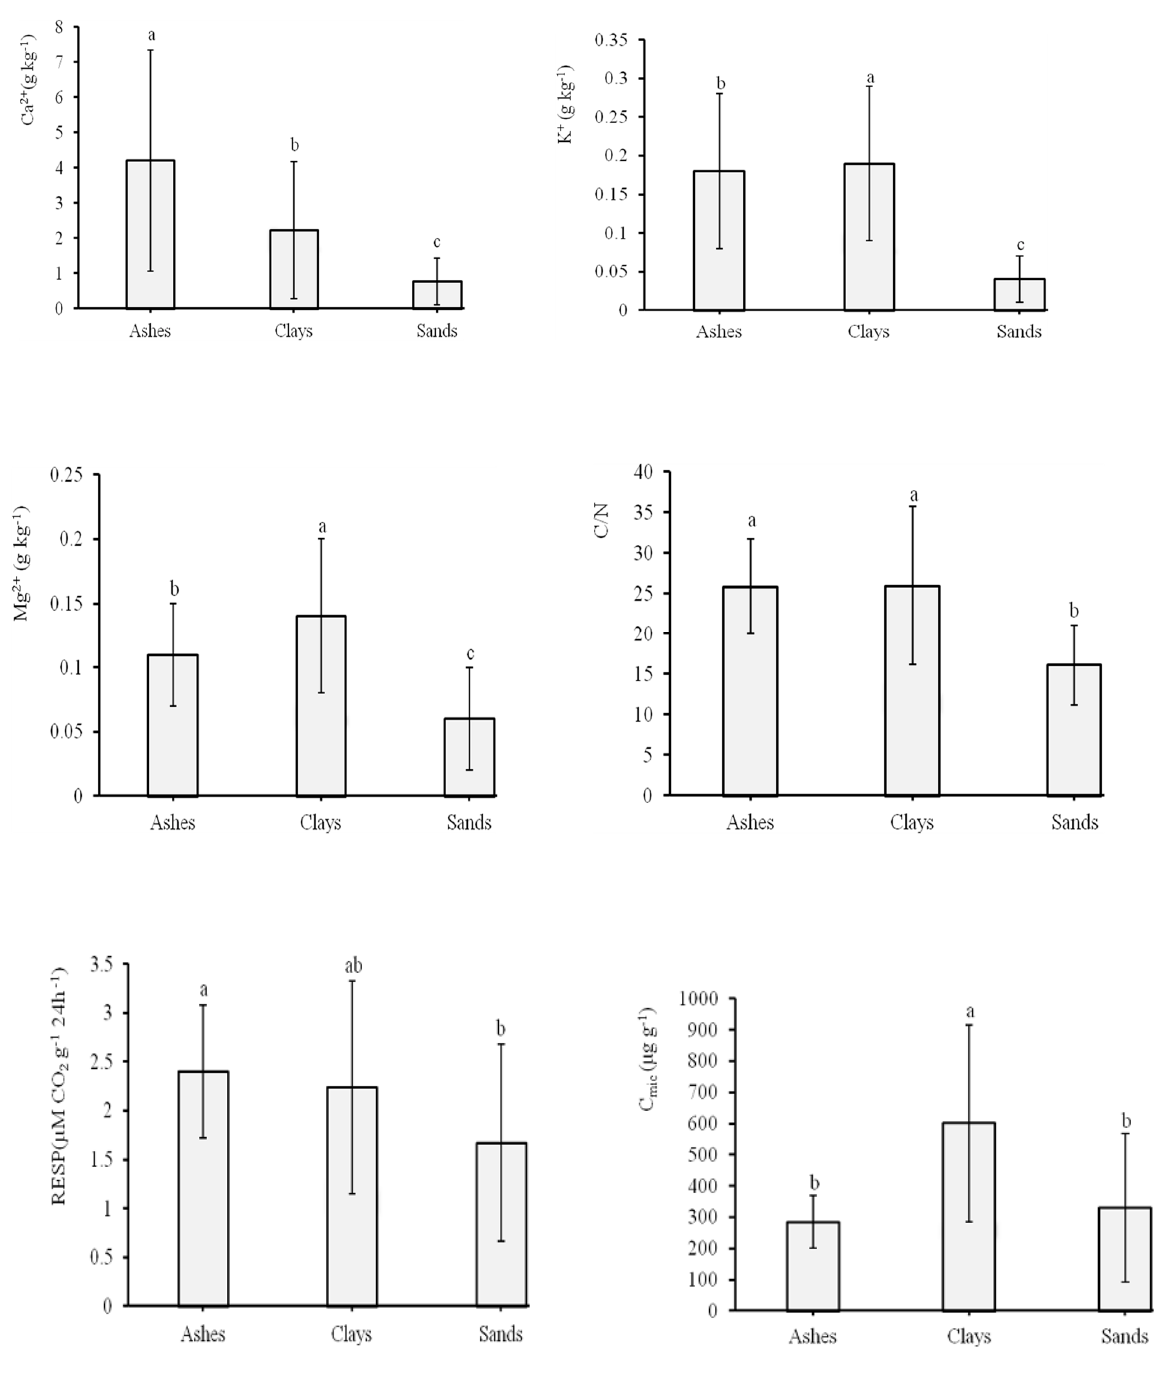
Figure 1. Substrate effect on soil chemical properties and microbial activities: C org —organic carbon, N t —total nitrogen, Ca 2+ —calcium, K + —exchangeable potassium, Mg 2+ —exchangeable magnesium, C:N—C to N ratio, RESP—basal respiration rate, and C mic —microbial biomass carbon. Means in each bar chart followed by different letters are significant at p < 0.05 level.